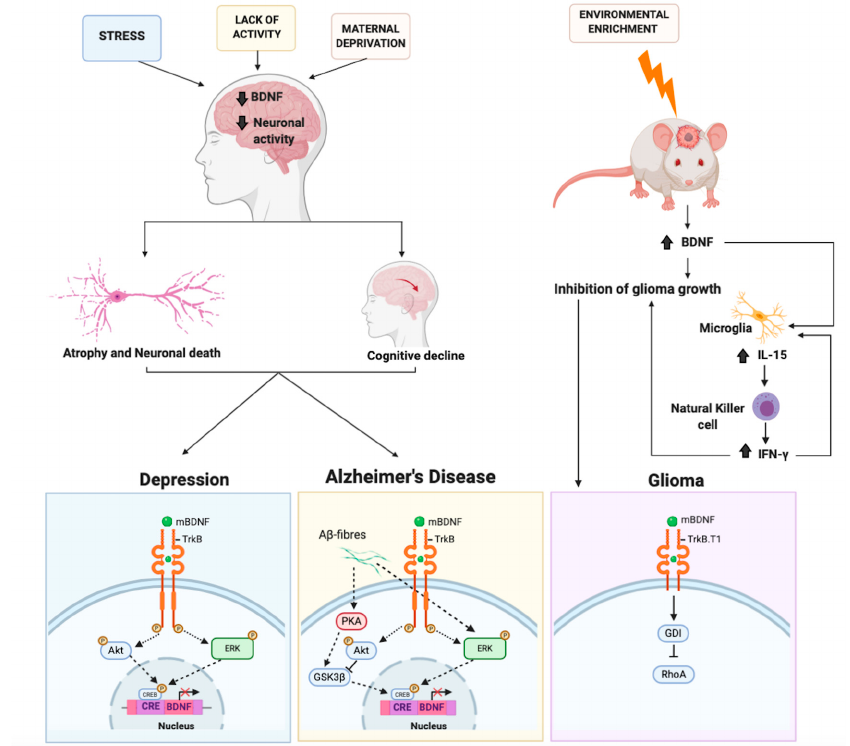
Figure 3. The molecular mechanisms mediated by BDNF involved in depression, Alzheimer’s disease, and glioma. External stimuli (stress, maternal deprivation, or lack of activity) causing epigenetic regulation processes can induce a reduction in BDNF expression level and in neuronal activity. This